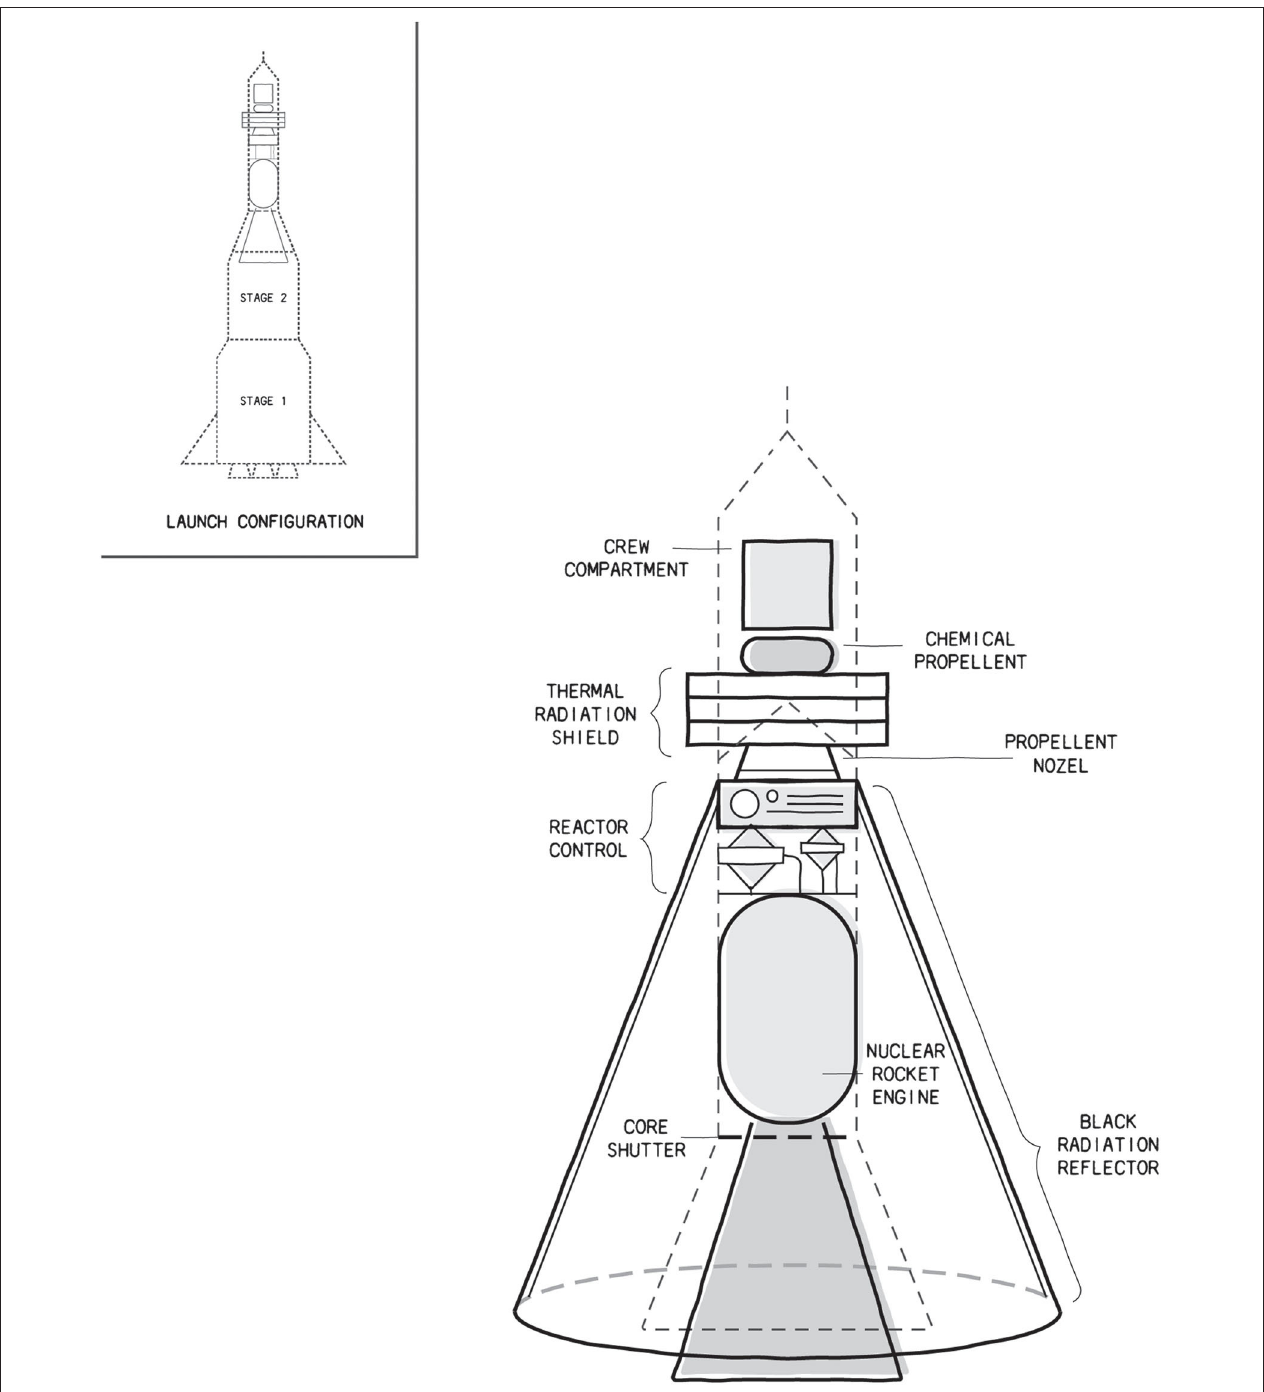
FIGURE 1 | Concept of the nuclear rocket, which will greatly reduce the crew’s exposure to ionizing radiation by reducing the transit time to/from Mars to less than a week. The payload/crew area is located in an excursion module that uses conventional propellant, and that will detach from the nuclear rocket for descent to Mars’ surface, and to re-enter Earth’s orbit and atmosphere. The nuclear section will include a very hot nuclear reactor, with a columnated ejection port, and an advanced thermal and particle radiation shield to protect the crew. The nuclear portion will be activated only when the rocket has been conventionally propelled to well-above Earth’s atmosphere, at about 100,000 miles from Earth. A radiation reflector will be deployed from alongside the spacecraft using a twisting radial actuator, once the spacecraft is well-away from Earth, and before the nuclear section is taken critical. As discussed, other forms of radiation protection may be added; however, the nuclear rocket approach will greatly reduce primary exposure by greatly reducing transit times to/from